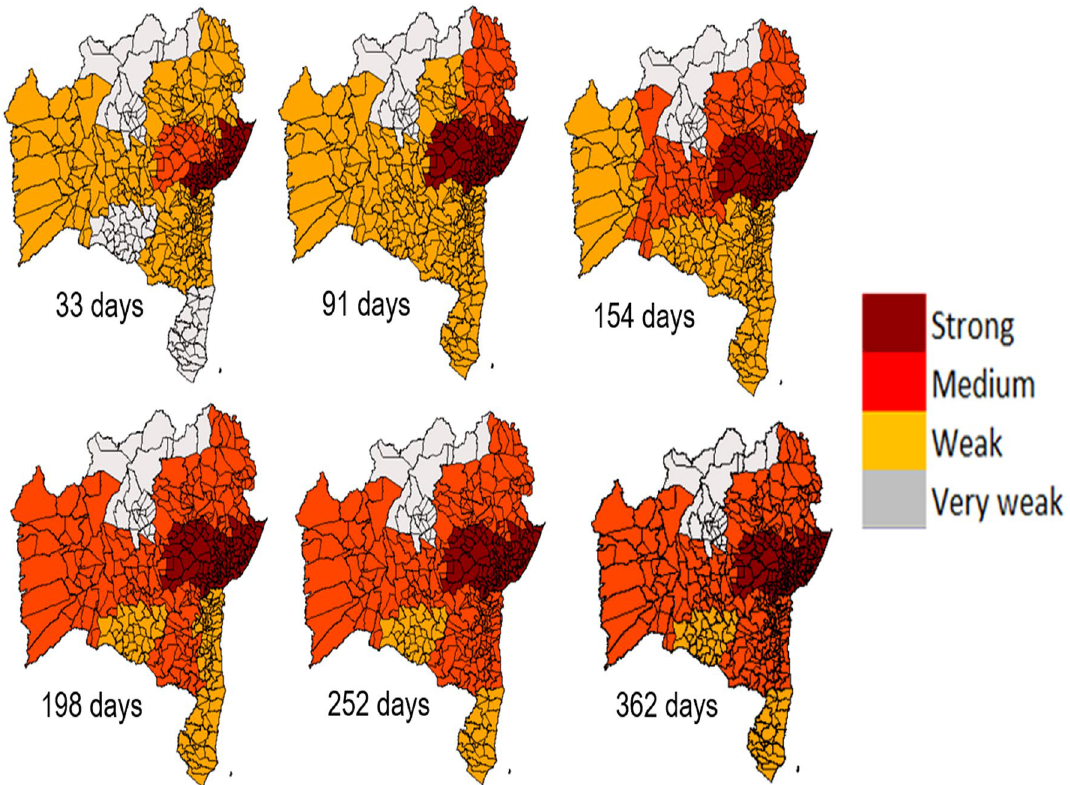
Figure 3. Correlation degree between RMS and all economic regions in Bahia-Brazil for different time scales. The value of the ρ DCCA between RMS and all ER presented a significant correlation. This was calculated for six scale days, 33, 91, 154, 198, 252 and 362 days. The ρ DCCA ’s ranges were associated with colors (Strong: ρ DCCA > 0.66 , Medium: 0.4 < ρ DCCA ≤ 0.66 , Weak: 0.2 < ρ DCCA ≤ 0.4 , and Very weak: ρ DCCA ≤ 0.2 ) to assist